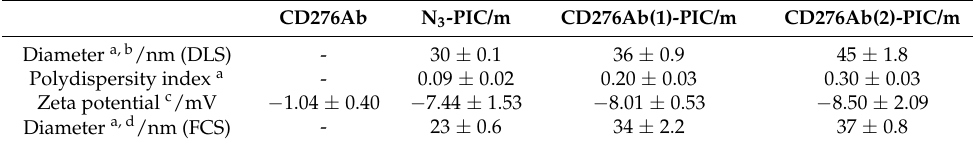
Table 1. Structural analysis by DLS and FCS before and after the introduction of CD276Ab to PIC/m